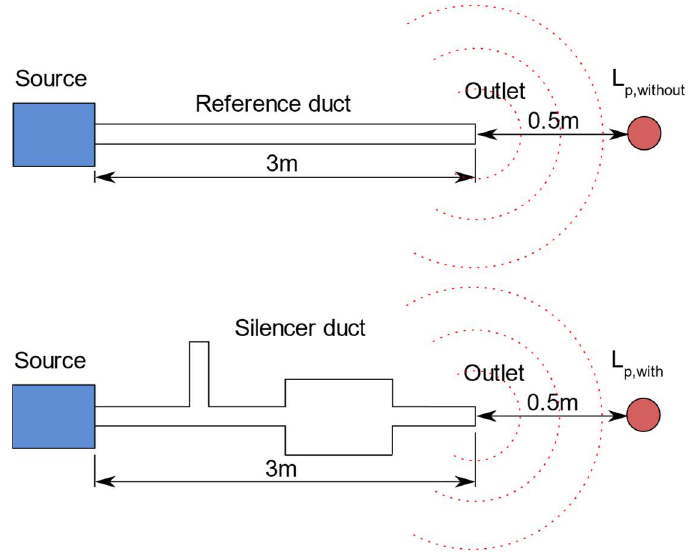
Figure 9. IL measurement outline.